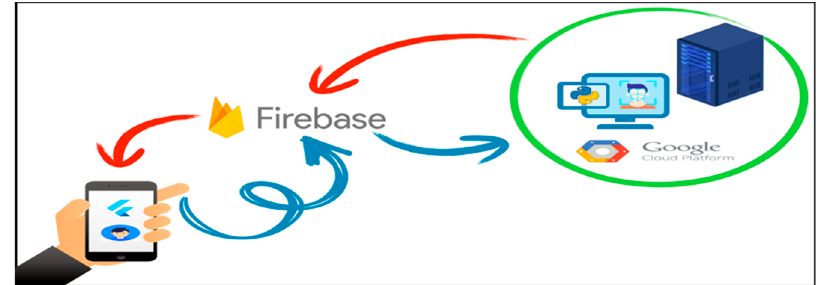
Figure 4. Describe the use of the Google Cloud platform and firebase on our